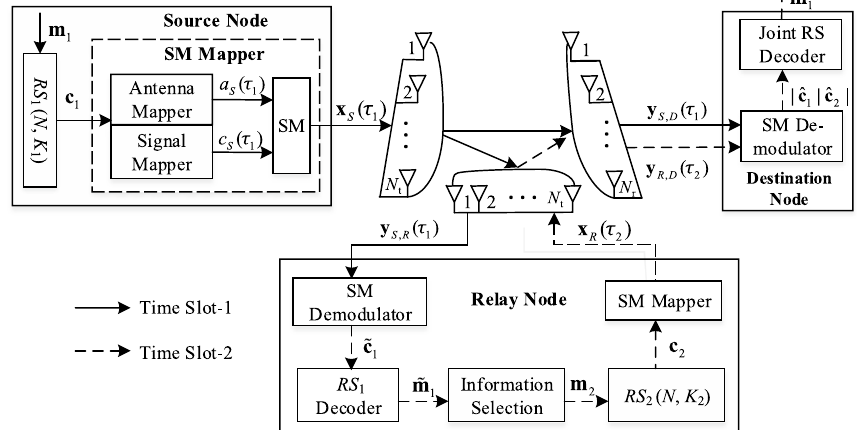
Fig. 2 DRSC-SM scheme for cooperative communications. The source S , relay R and destination D are equipped with N t , N t and N r antennas, respectively. The RS codes RS 1 and RS 2 are employed at the source and relay nodes, respectively. During time slot 1, the source node encodes the information sequence m 1 into codeword c 1 , which is given into SM mapper. The generated transmission vector is then sent to relay and destination nodes. During time slot 2, the demodulated codeword by the SM demodulator at the relay node is fed into the RS 1 decoder to generate the estimated information sequence. After the RS 2 encoder, the codeword c 2 is generated and further sent to the SM mapper. Then, the generated transmission vector at the relay is sent to destination node. At the common destination node, the SM demodulator demodulates the received vectors during their time slots. Finally, the joint RS decoder is performed to jointly decode